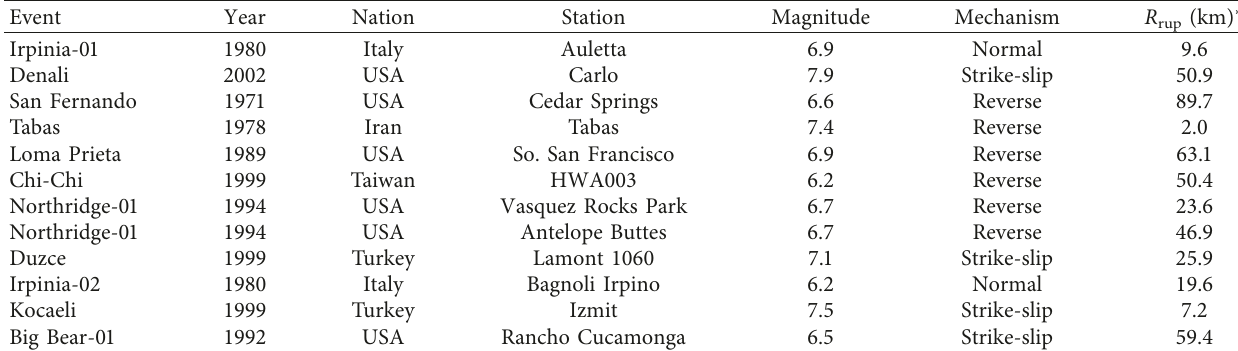
Figure 4: Nonlinear properties of the soil and rock. (a) Shear modulus. (b) Damping ratio. Table 2: Properties of 12 recorded